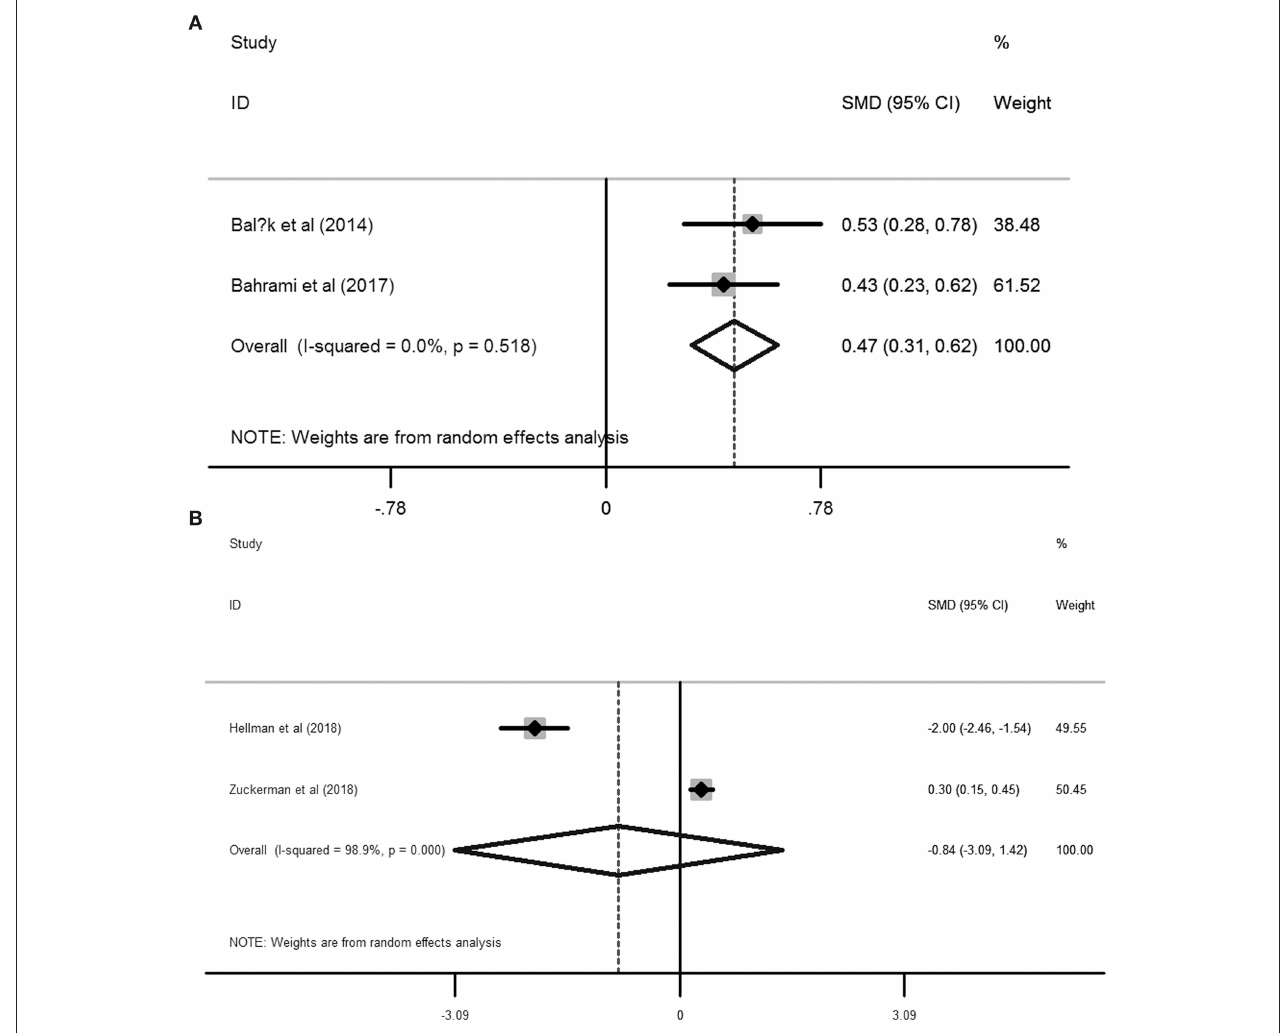
FIGURE 3 | Forest plots of meta-analysis based on the two studies reporting the BDI scores (A) and the two studies reporting the PROMIS T-Score (B) .